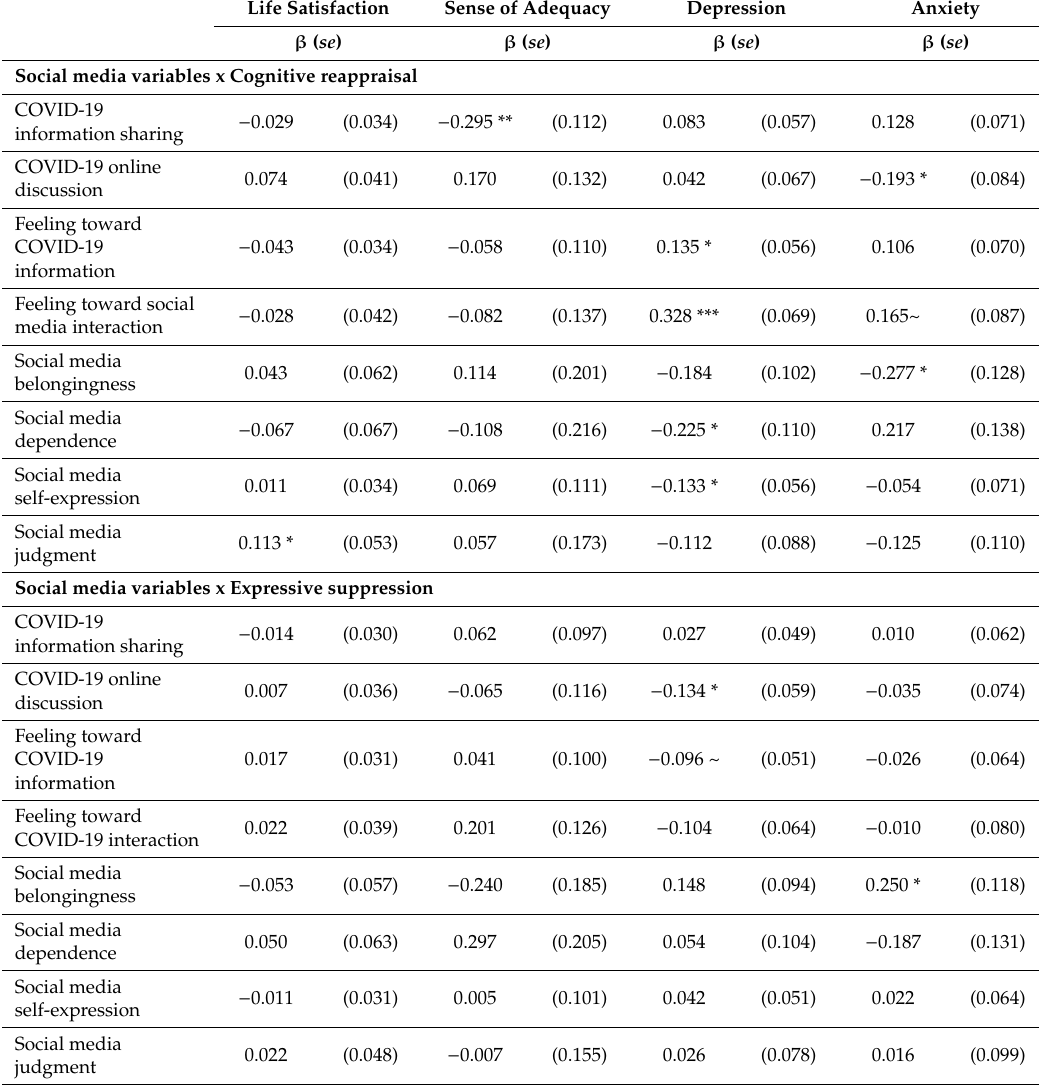
Table 4. Interaction results on life satisfaction, sense of adequacy, depression, and